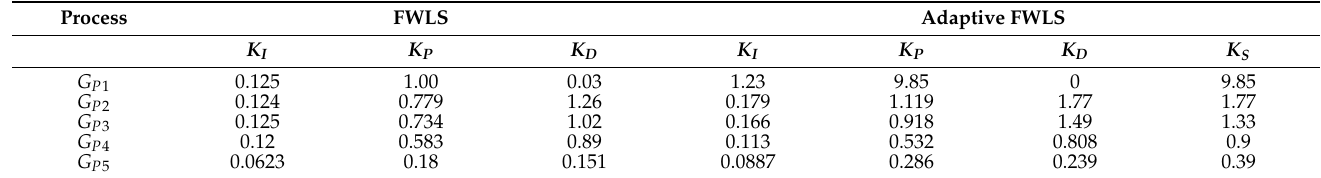
Table 2. PID controller parameters for considered models.